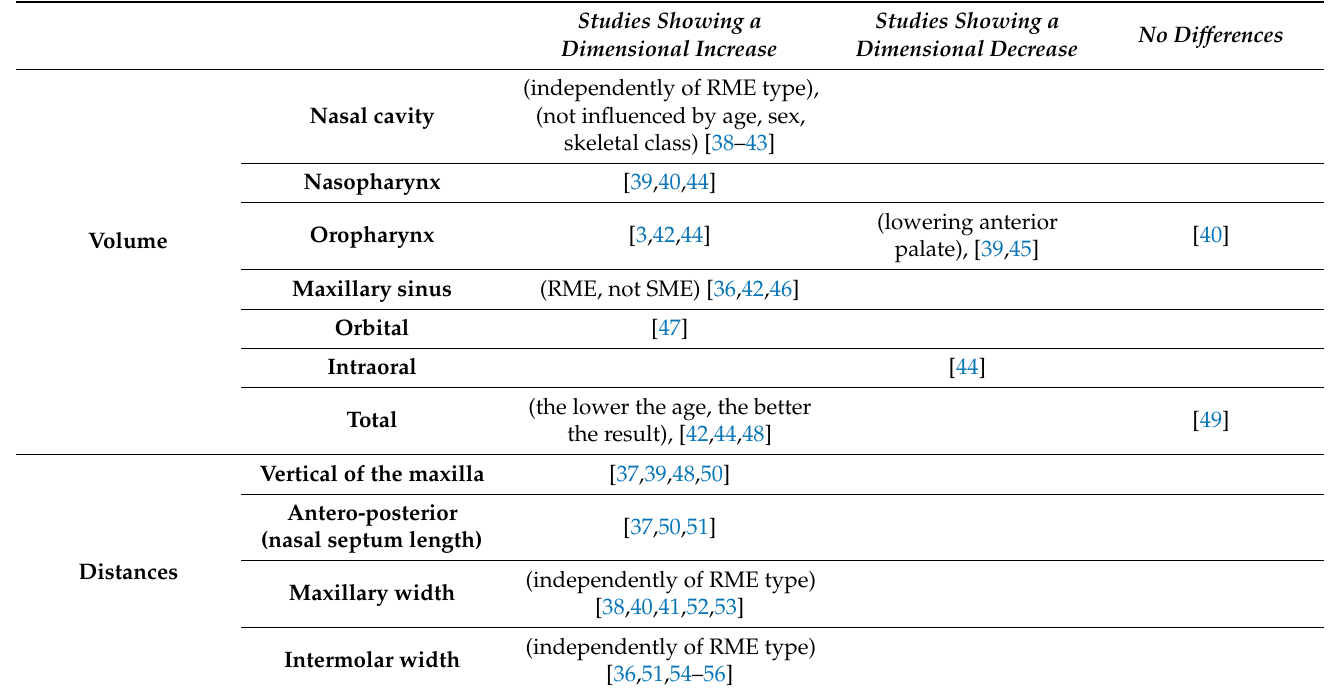
Table 4. Reported effects of RME on airway dimensions and